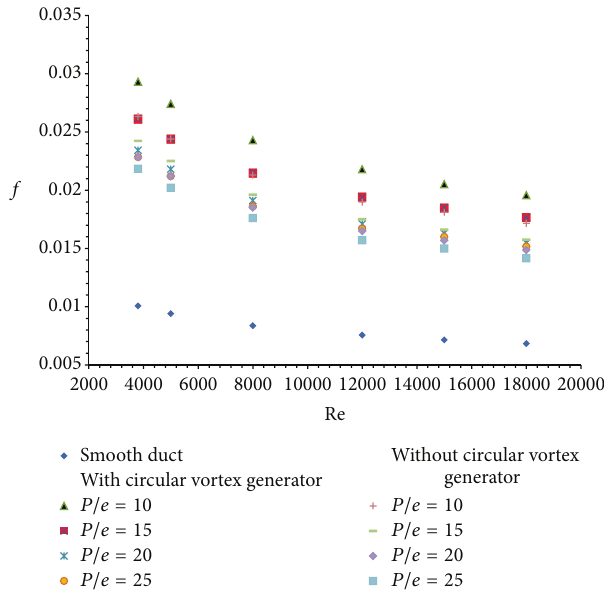
Figure 10: Variation of average friction factor ( 𝑓 ) with Reynolds number (Re).